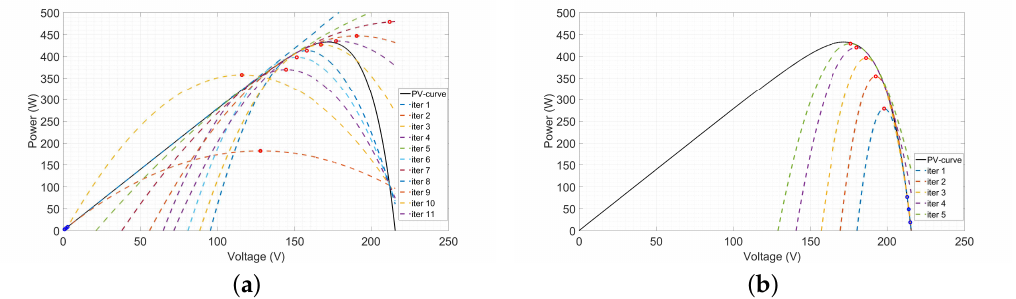
Figure 18. NQI tracking process under 100% irradiation with initial points ( a ) 1 V, 2 V, 3 V; ( b ) 213 V, 214 V, 215 V.